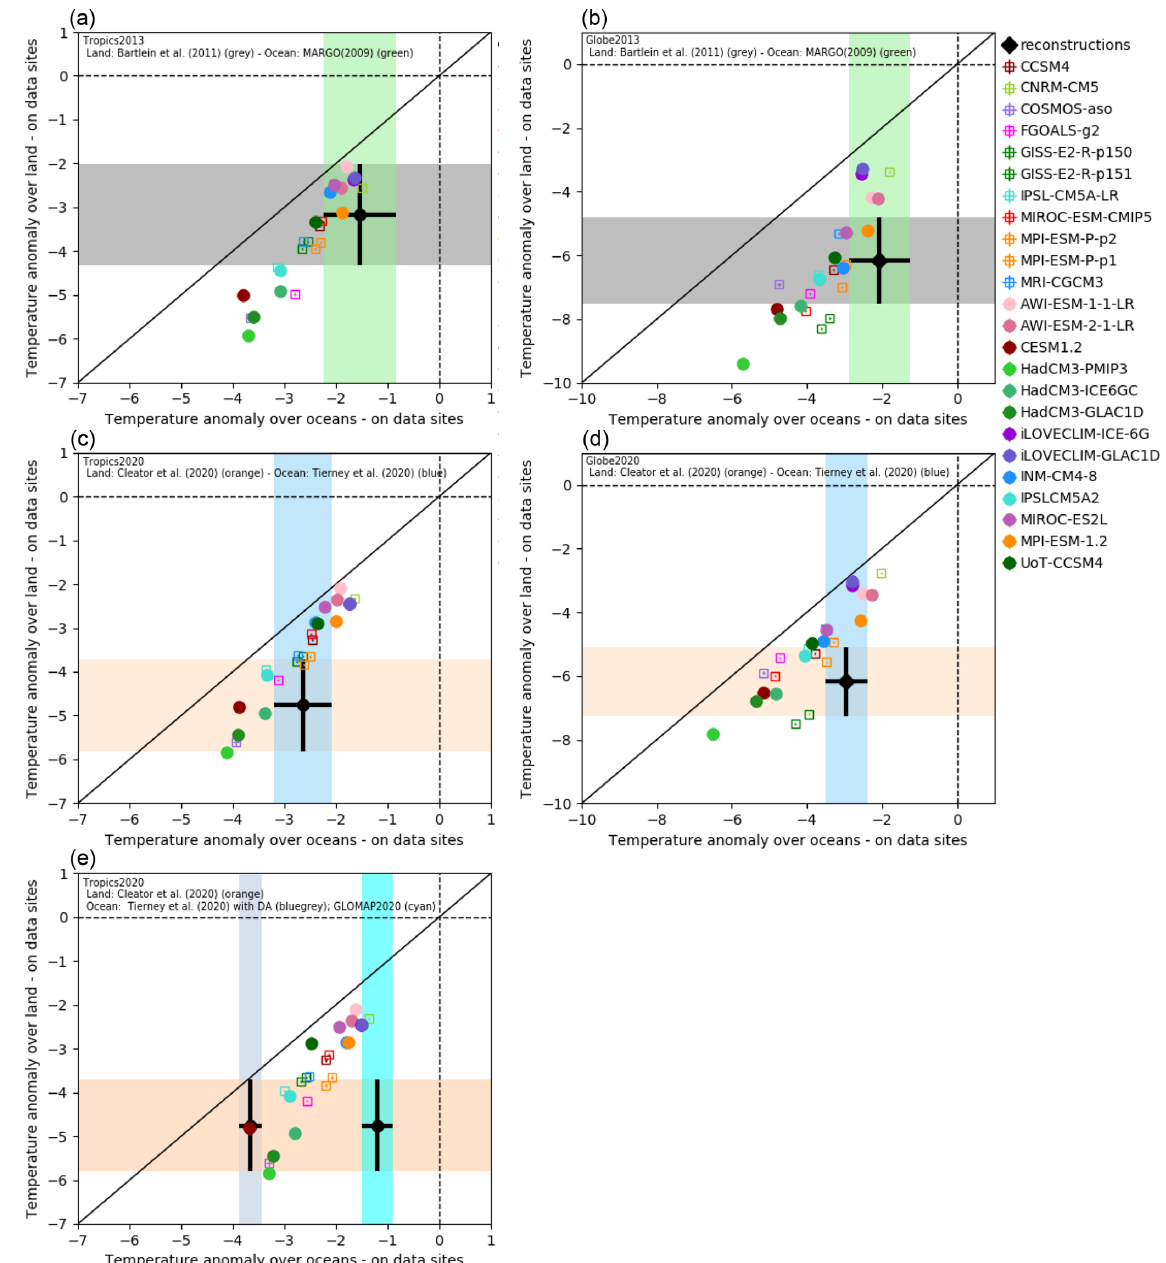
Figure 10. LGM–PI mean annual temperature anomaly over land vs. LGM–PI mean annual temperature anomaly over oceans, averaged over the tropics (30 ◦ S–30 ◦ N, left-hand side) and over the globe (right-hand side). The model output considered for the averages is taken only on grid points for which there are reconstructions. The top plots are based on the reconstructions used to evaluate the PMIP3-CMIP5 models: the Bartlein et al. (2020) database and the MARGO (2009) SST reconstructions. The bottom plots are based on the most recent reconstructions: Cleator et al. (2020) for terrestrial data and Tierney et al. (2020) for the